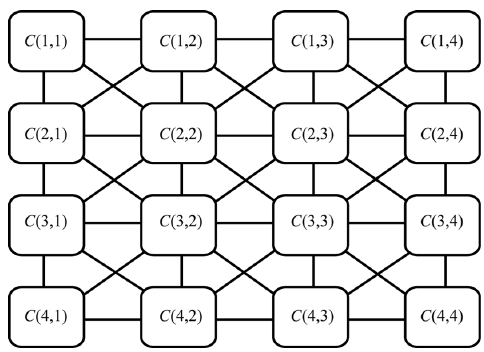
Fig. 1. A 2D CNN. The circuit size is 4 × 4. The link between cells (squares) indicate interactions between the linked cells.